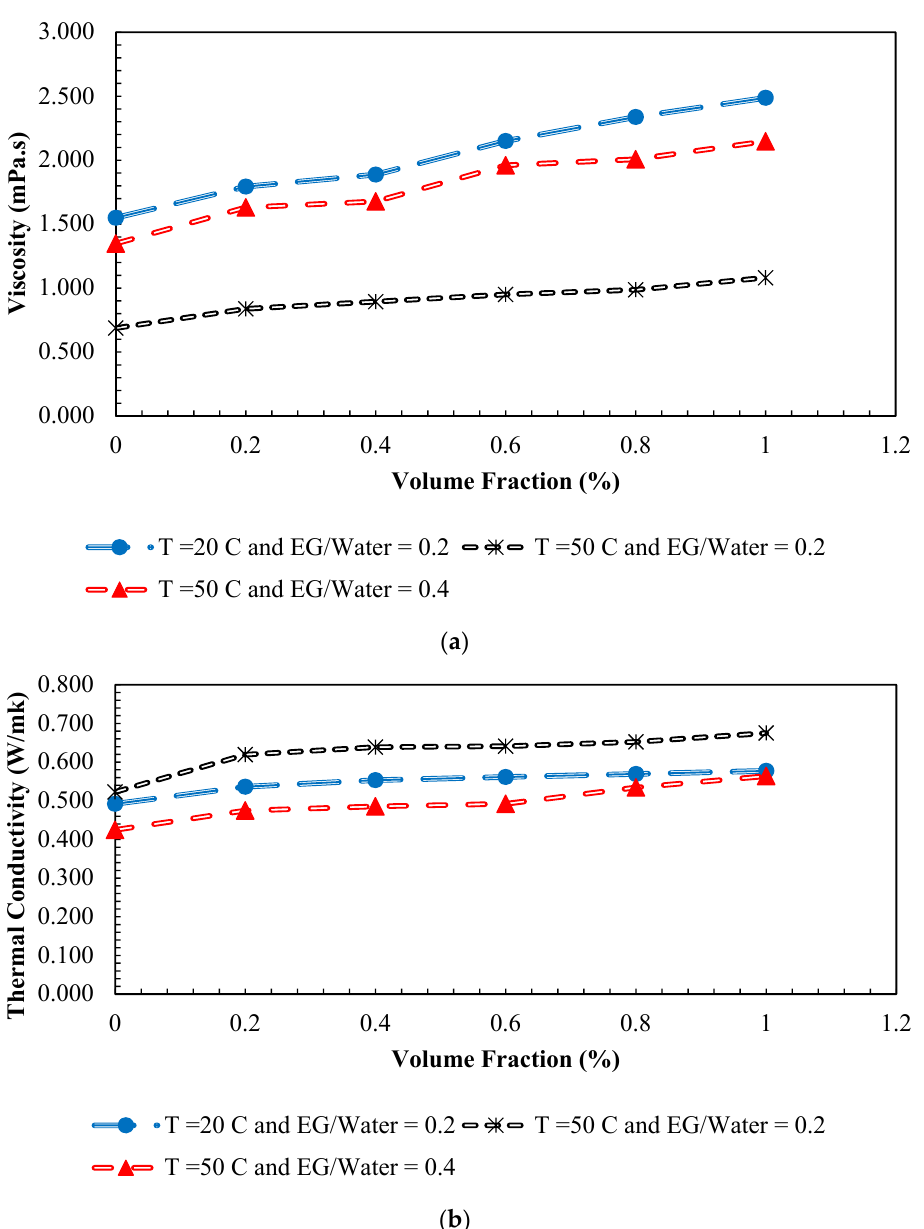
Figure 5. Variation of viscosity ( a ) and thermal conductivity ( b ) versus volume fraction at different temperatures.